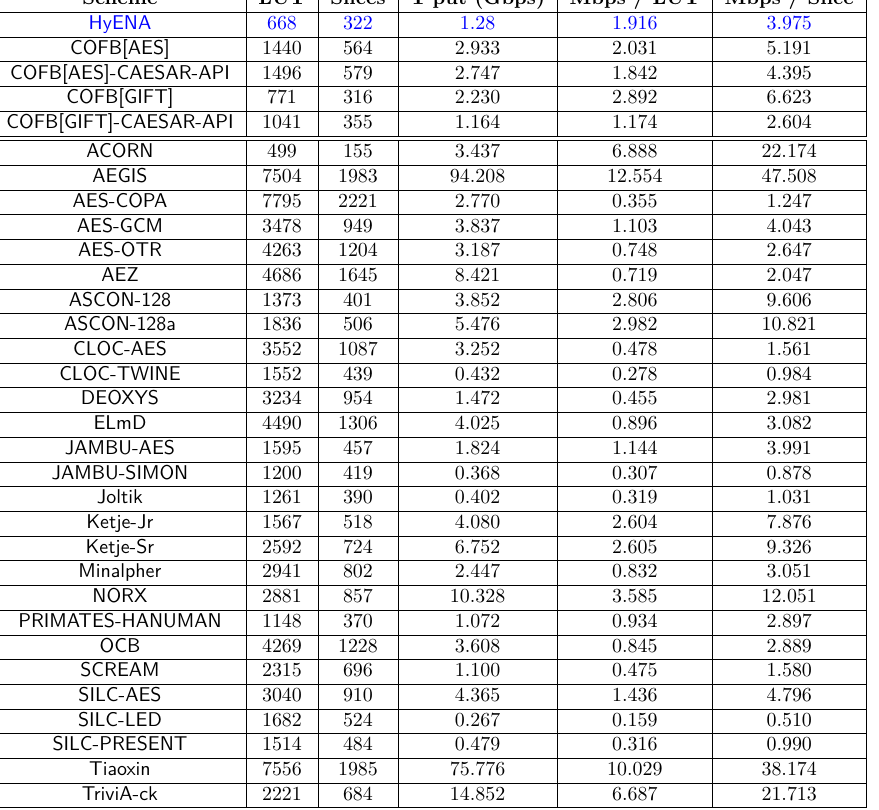
Table 4: Comparison on Virtex 7 [ATH] (Results are taken by selecting CAESAR Round 2 and Standards implemented results (following CAESAR API) in [ATH]). The results for CLOC-AES-Optimized and NORX-Optimized implementations (based on custom API, but not CAESAR API) have been taken from [KHKC17]. Results for COFB have been taken from [CIMN17b]. ‘-‘ implies data not available